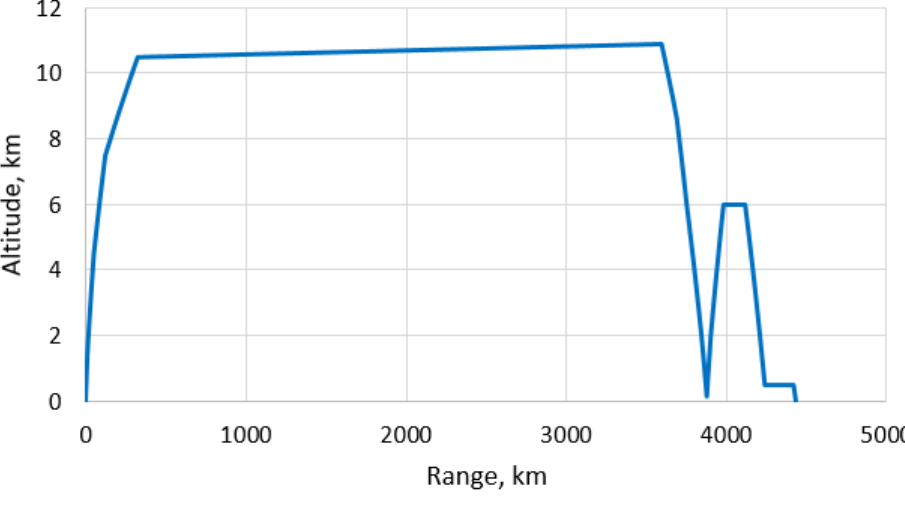
Figure 4. A320-200 mission